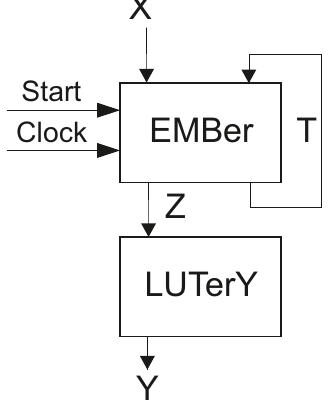
Figure 3. Structural diagram of FSM U 3